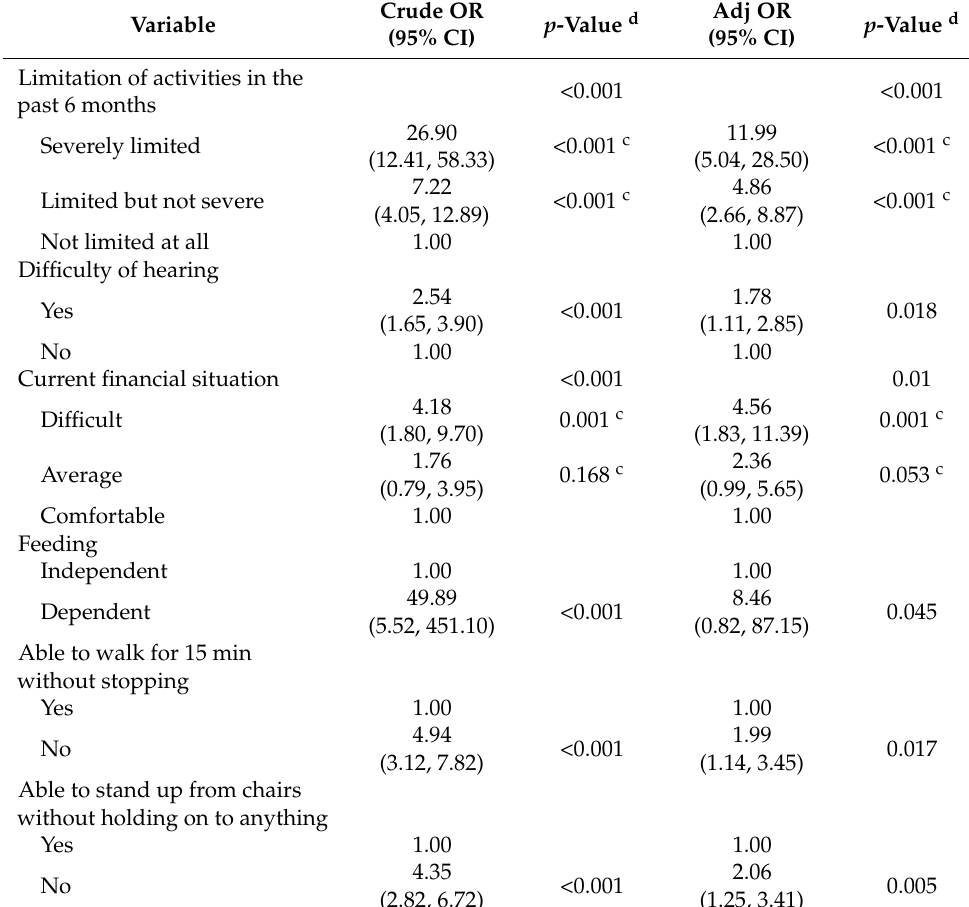
Table 5. Overall factors and daily living activities associated with the need for